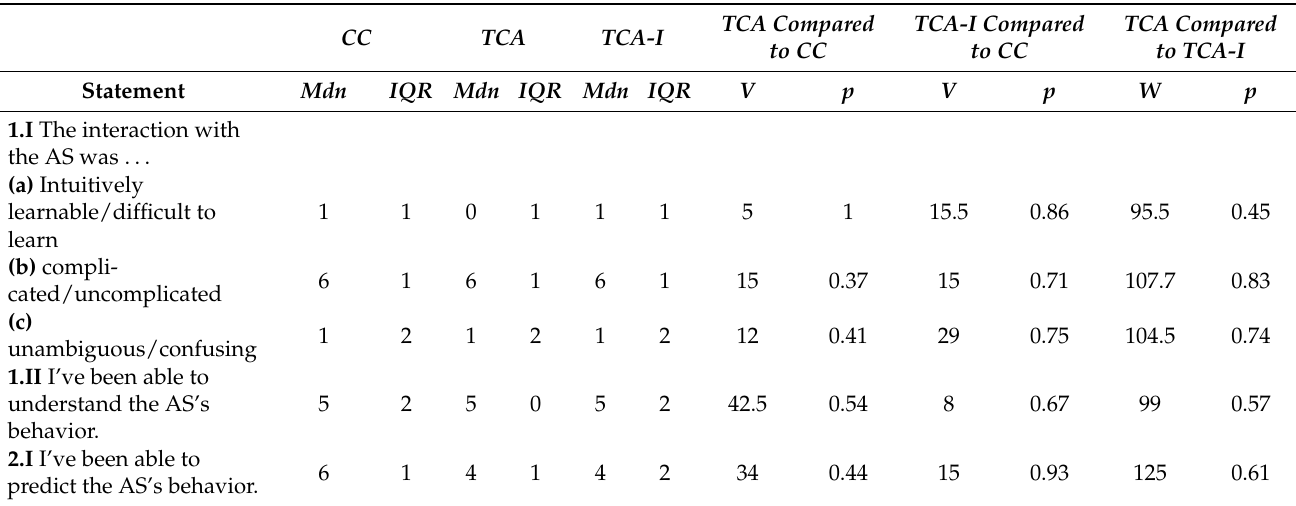
Table 6. Summary of pairwise comparisons for Wilcoxon signed rank test and Wilcoxon rank-sum test of statements concerning perceived predictability and comprehensibility of the AS’s